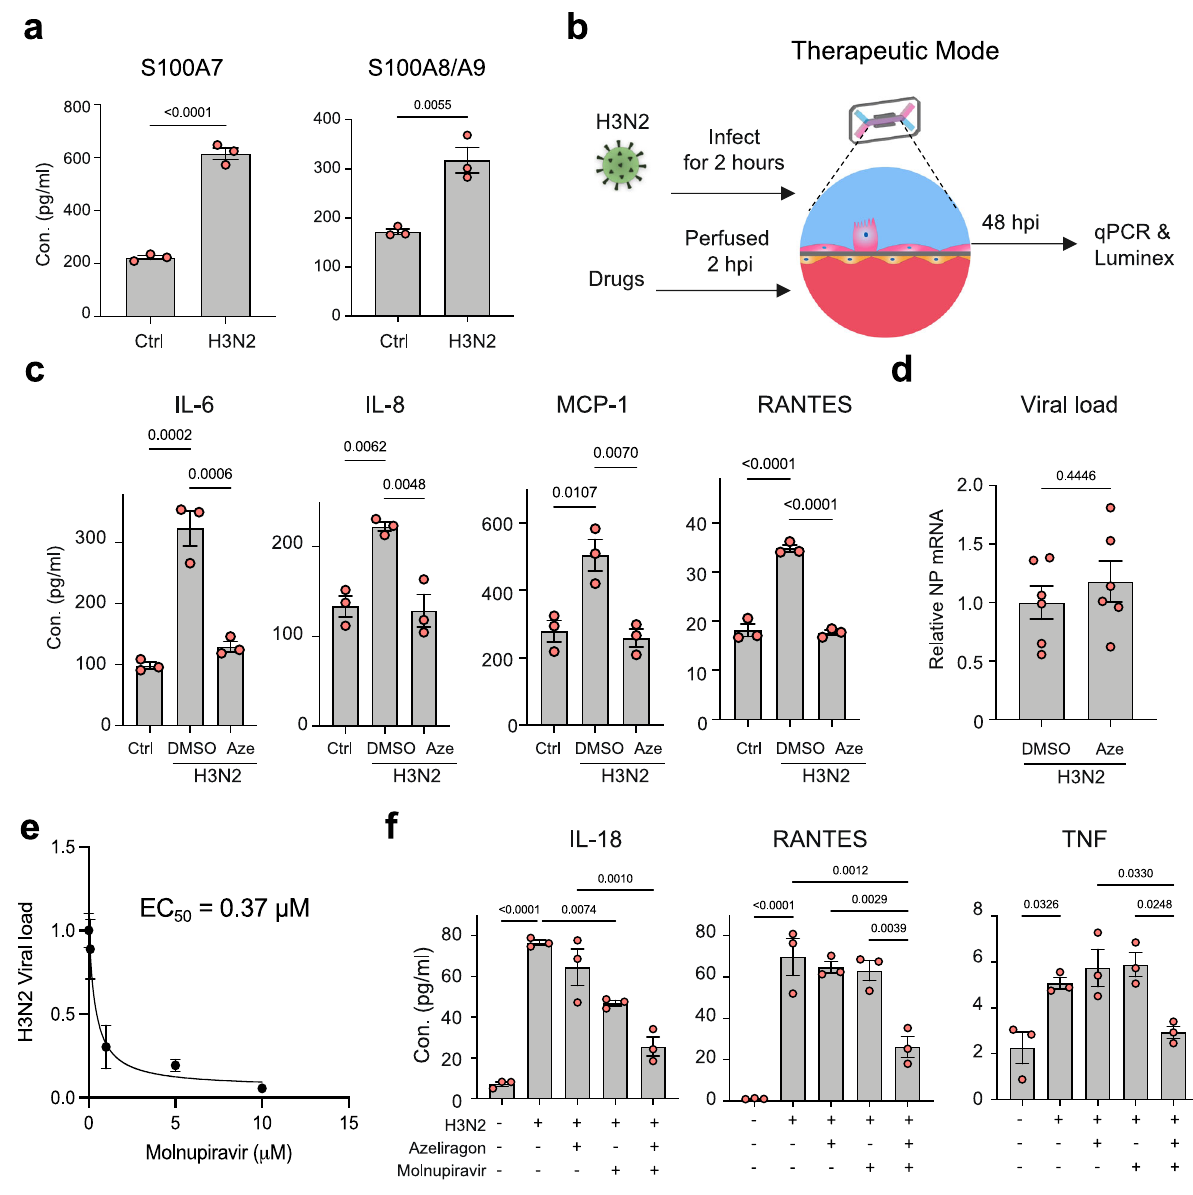
Fig. 8 RAGE inhibitor azeliragon suppresses viral host in fl ammation responses and produces synergistic effects with molnupiravir when administered 2 h after infection. a Graph showing the protein levels of S100A7 (left) and S100A8/A9 (right) in the vascular ef fl uents of the alveolus chips at 48 hpi with HK/68 (H3N2) virus (MOI = 1) in the presence of 5% strain. Data represent mean ± SD; n = 3 biological chip replicates; unpaired two-tailed t -test. b Illustration of drug study on the human alveolus chip. c Graphs showing the levels of cytokines in the vascular ef fl uents of alveolus chips that were uninfected (Ctrl), or infected with HK/68 (H3N2) (MOI = 1) in the presence or absence of 100 nM Azeliragon (Aze). Data are shown as mean ± SD; n = 3 biological chip replicates; one-way ANOVA with Dunnett ’ s multiple comparisons test. d Graph showing that azeliragon (100 nM) had no effect on viral load when administered 2 h after infection. Data are shown as mean ± SEM; n = 6 biological chip replicates; unpaired two-tailed t -test. e Plot showing the effect of molnupiravir at different concentrations on H3N2 viral load determined on human Alveolus Transwell. Data are shown as mean ± SD; n = 2 biological replicates. EC50 (half maximal effective concentration) was determined by a variable slope fi tting with four parameters. f Graphs showing that azeliragon (100 nM) and molnupiravir (500 nM) drug combo synergistically reduce the levels of cytokines in the vascular ef fl uents of alveolus chips infected with H3N2 virus. Data are shown as mean ± SEM; n = 3 biological chip replicates; one-way ANOVA with Dunnett ’ s multiple comparisons test. Source data are provided as a Source Data fi